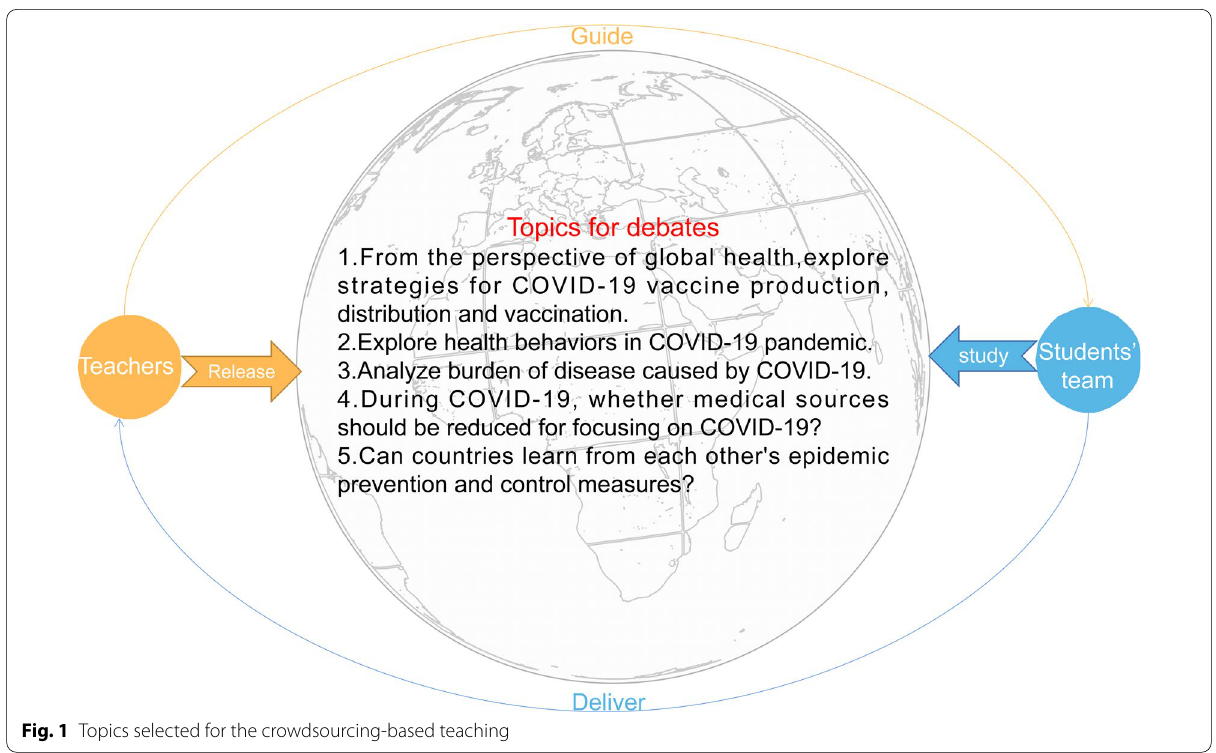
Fig. 1 Topics selected for the crowdsourcing-based teaching